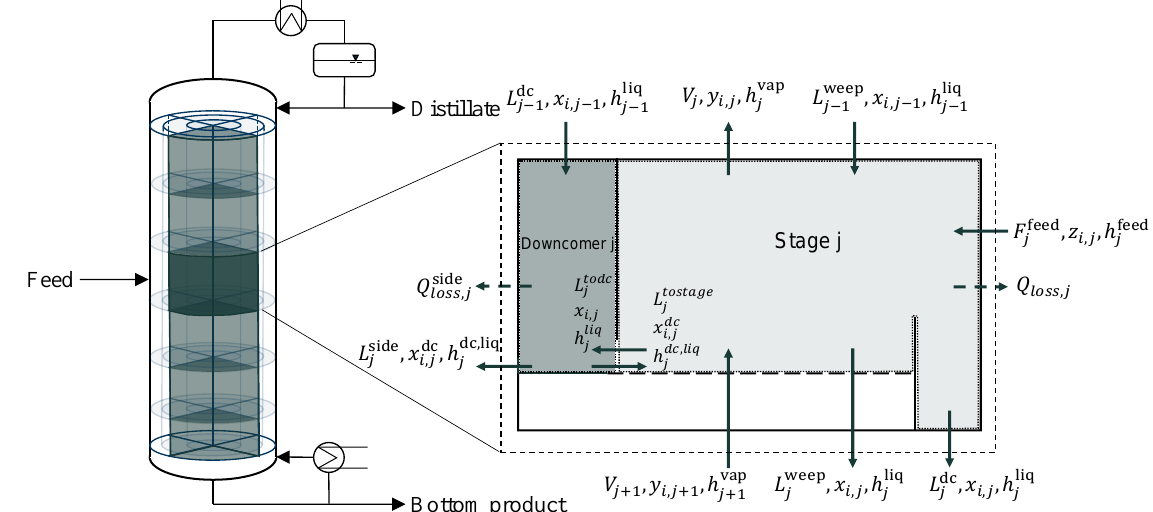
Figure 2. Schematic representation of a tray in the segmented column, divided into downcomer and equilibrium stage.